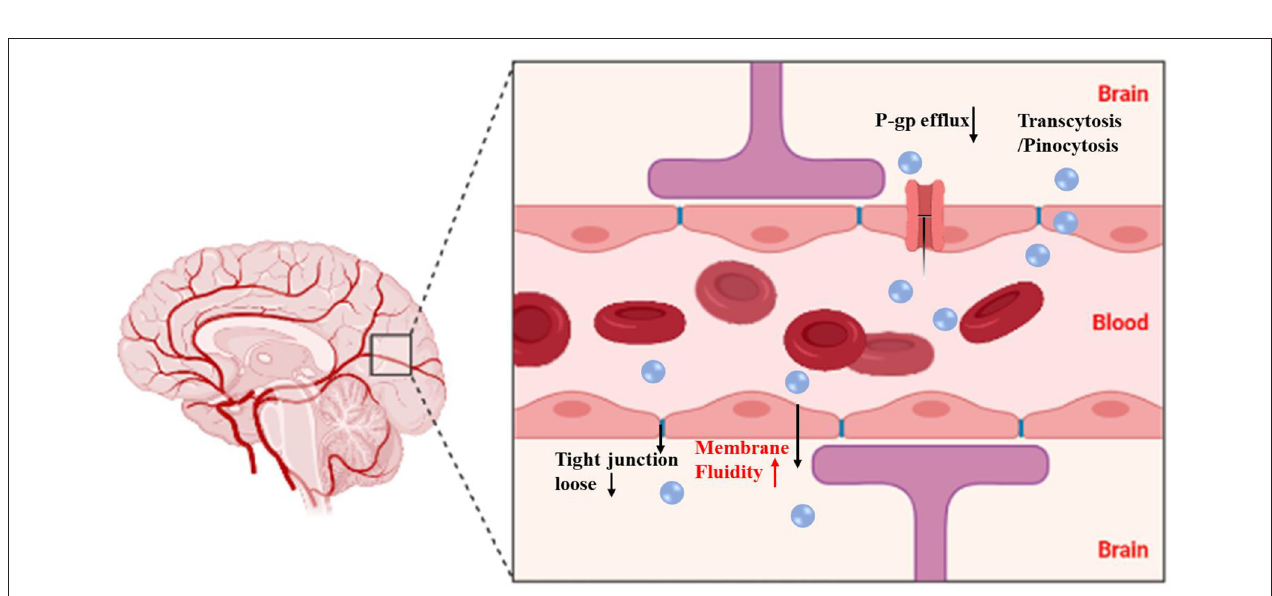
FIGURE 4 | Schematic illustration of the application of the borneol combined CGKRK peptide modified paclitaxel prodrug self-assembled redox-responsive nanoparticles (CGKRK-PSNPs) for brain targeting in glioma treatment.